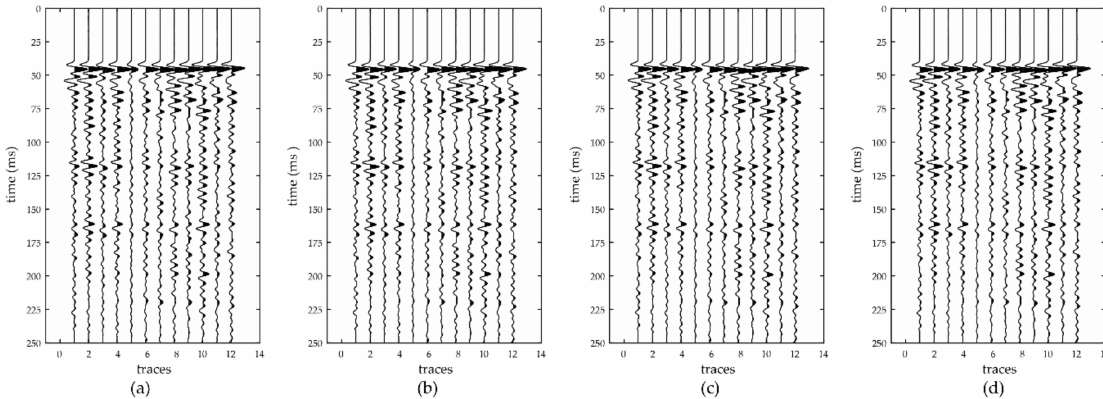
Figure 6. Using the calculation results of relative arrival times as the adjusting value to eliminate the arrival time difference among traces. ( a – d ) Akaike Information Criterion (AIC), cross-correlation, phase-only correlation (short time Fourier transform) (POC (STFT)), and phase-only correlation (Wigner-Ville distribution) (POC (WVD)) were used to estimate the relative arrival times of the P-wave record.